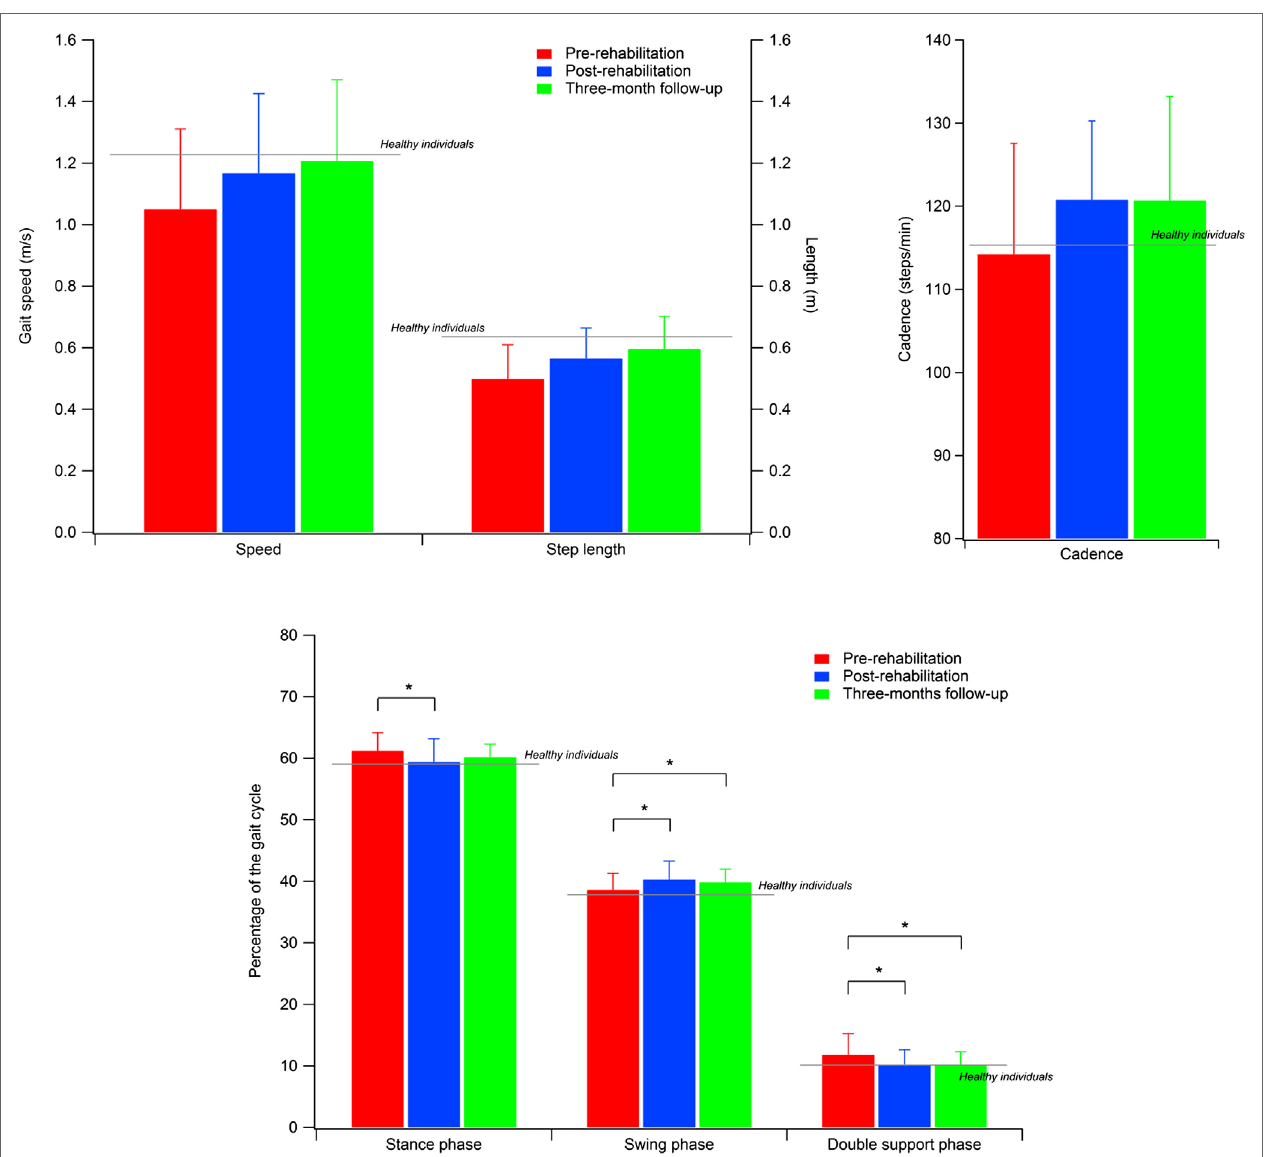
FigUre 1 | spatial–temporal parameters of the participants with PD . Gray lines indicate the reference values calculated for a sample of healthy individuals. Error bars indicate